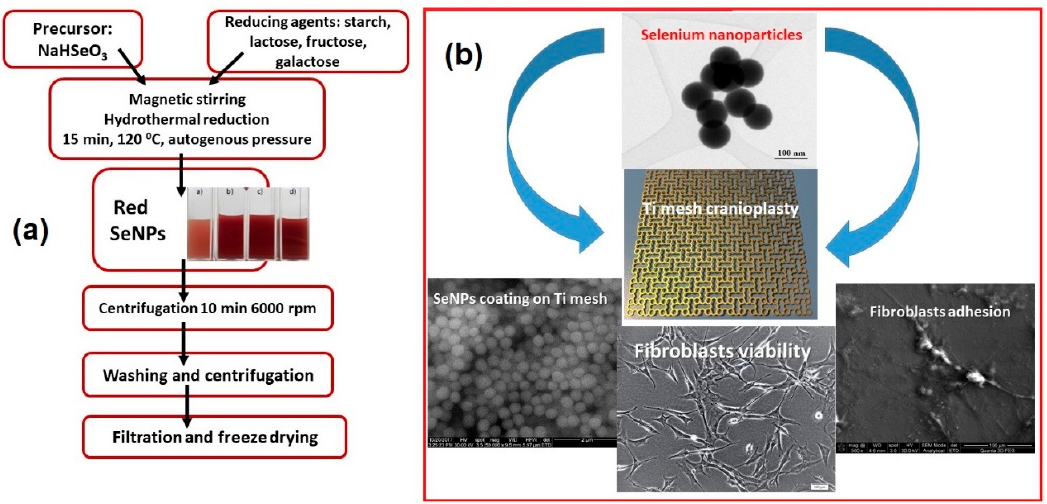
Figure 4. ( a ) The flow chart of SeNPs production via hydrothermal reaction using different saccharides as reducing agent; ( b ) TEM image of SeNPs used for the surface modifications of Ti mesh for cranioplasty, along with the surface morphology of the coating upon in situ SeNPs deposition and details of fibroblasts adhesion on the nanostructured Ti surface.